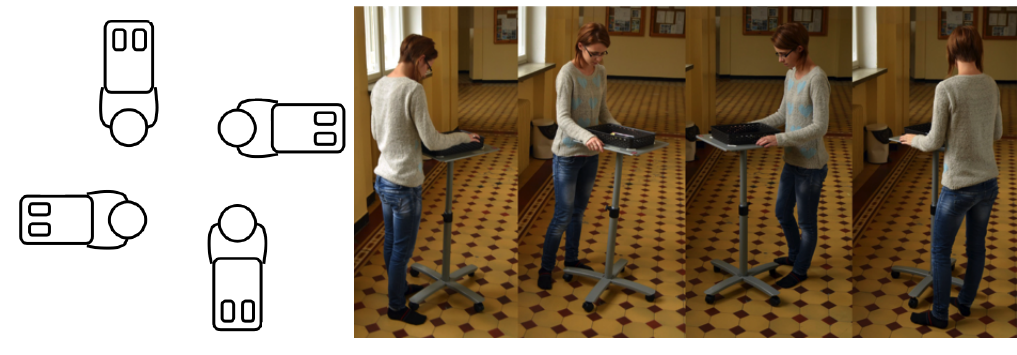
Figure 2. Measurement procedure.